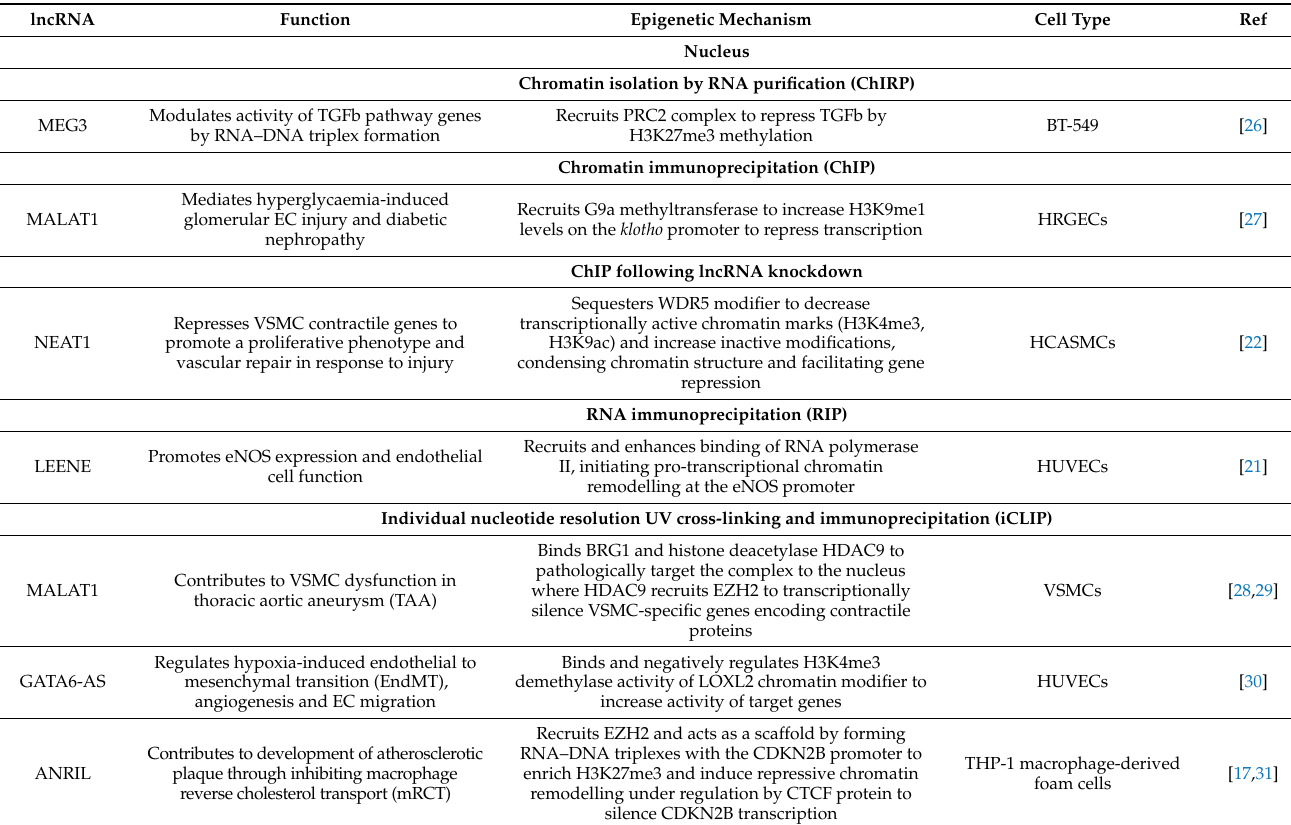
Table 1. Epigenetic mechanisms of nuclear vascular lncRNAs and approaches used to explore their